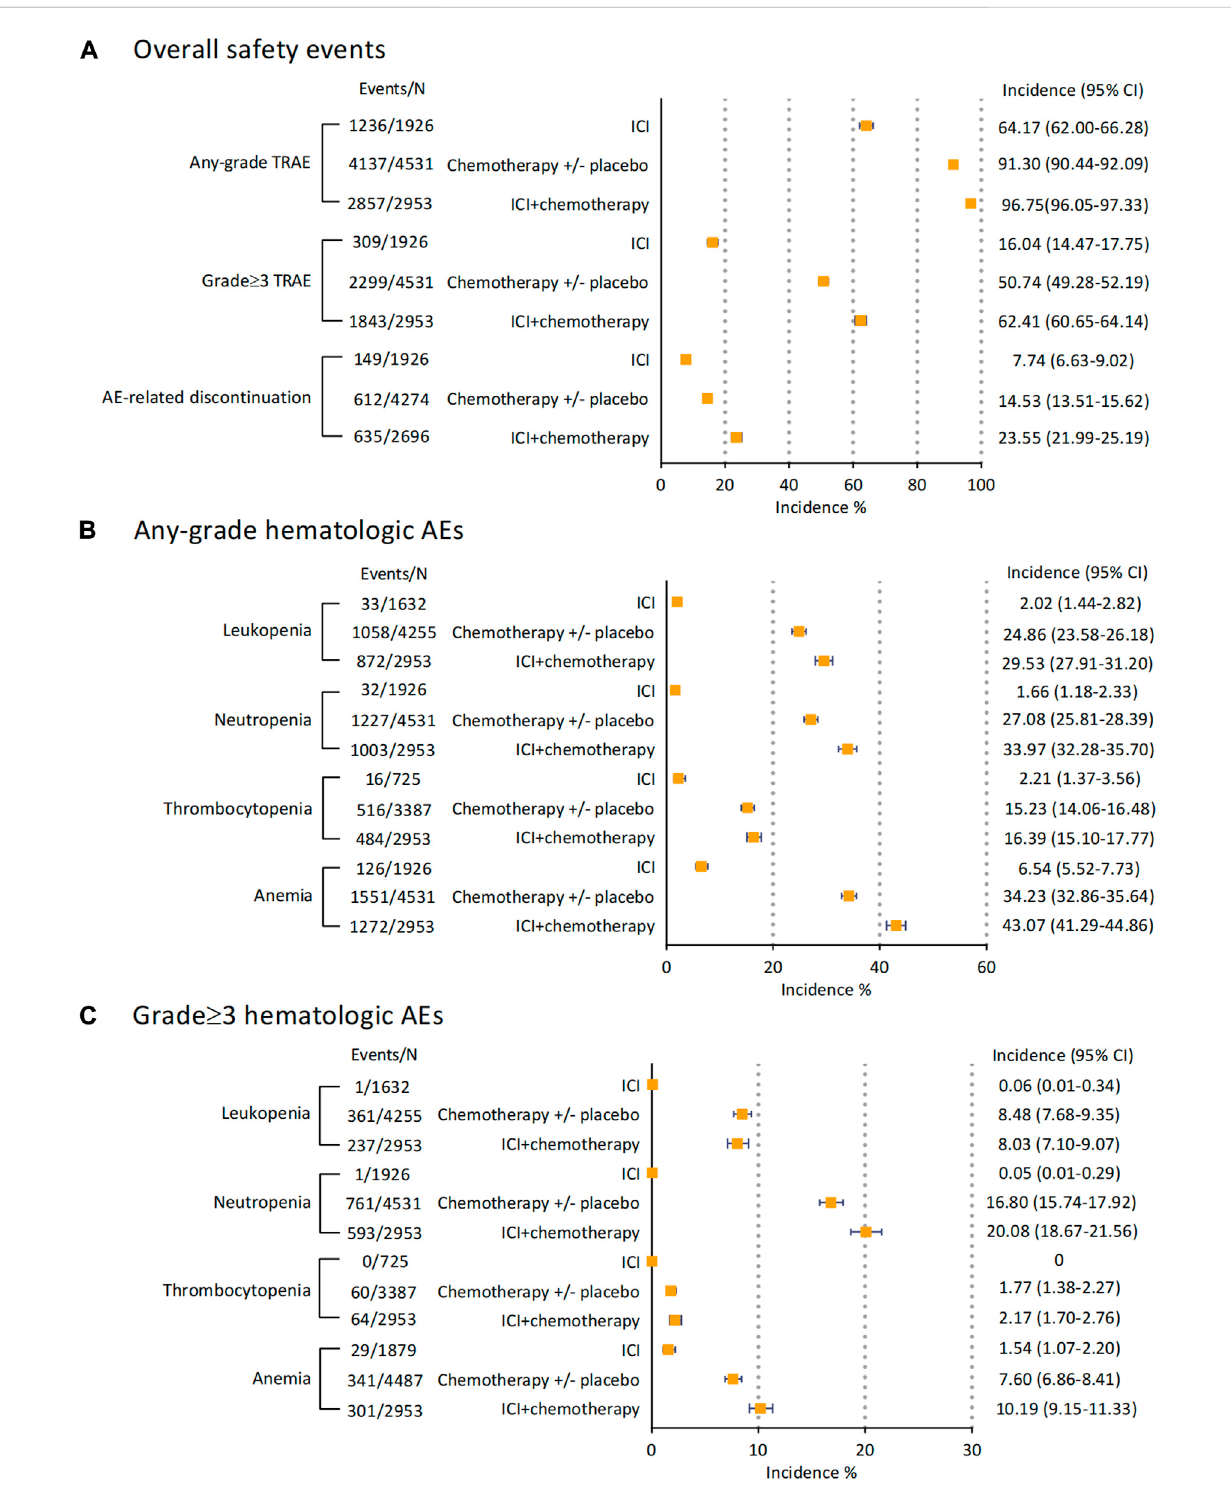
FIGURE 4 Incidences of overall safety events and hematological AEs of ICI monotherapy, ICI combined with chemotherapy, and chemotherapy with/without placebo. (A) incidences of overall safety events. (B) incidences of any-grade hematological AEs. (C) incidences of grade 3 hematological AEs. Abbreviation: AE, adverse event; ICI, immune checkpoint